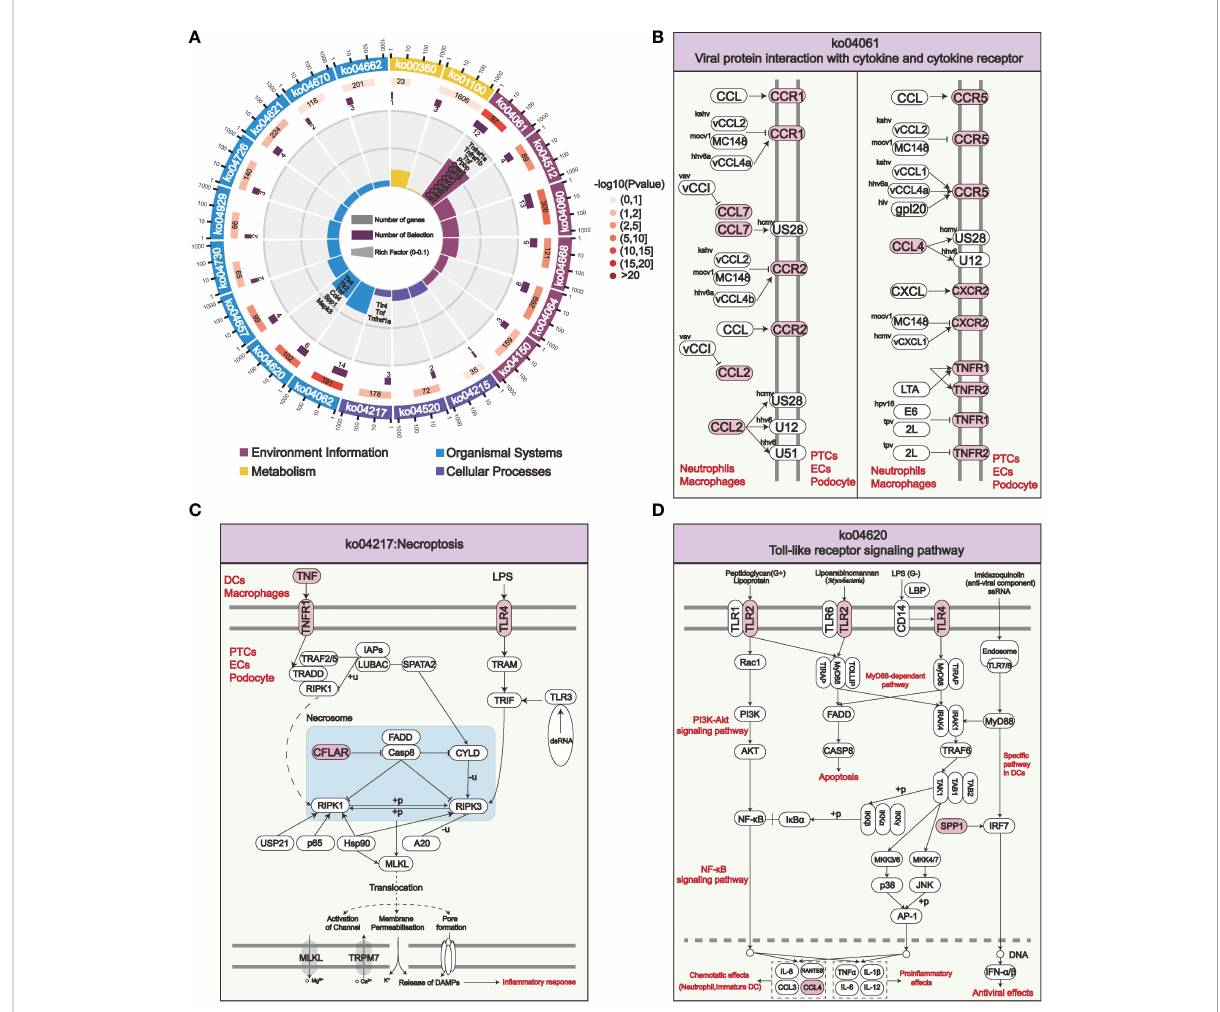
FIGURE 7 KEGG enrichment analysis of the PPI-hub genes and activated intercellular immunostimulatory and chemokine-related ligand receptors for COVID-19 kidney injury. (A) The most signi fi cantly enriched pathways in the four major classes of KEGG are shown. (B – D) Viral protein interaction with cytokine and cytokine receptor (B) , necroptosis (C) , and Toll-like receptor signaling pathways (D) are activated among speci fi c immune cells and parenchymal cells in the kidney, these pathways may be crucial for COVID-19 renal